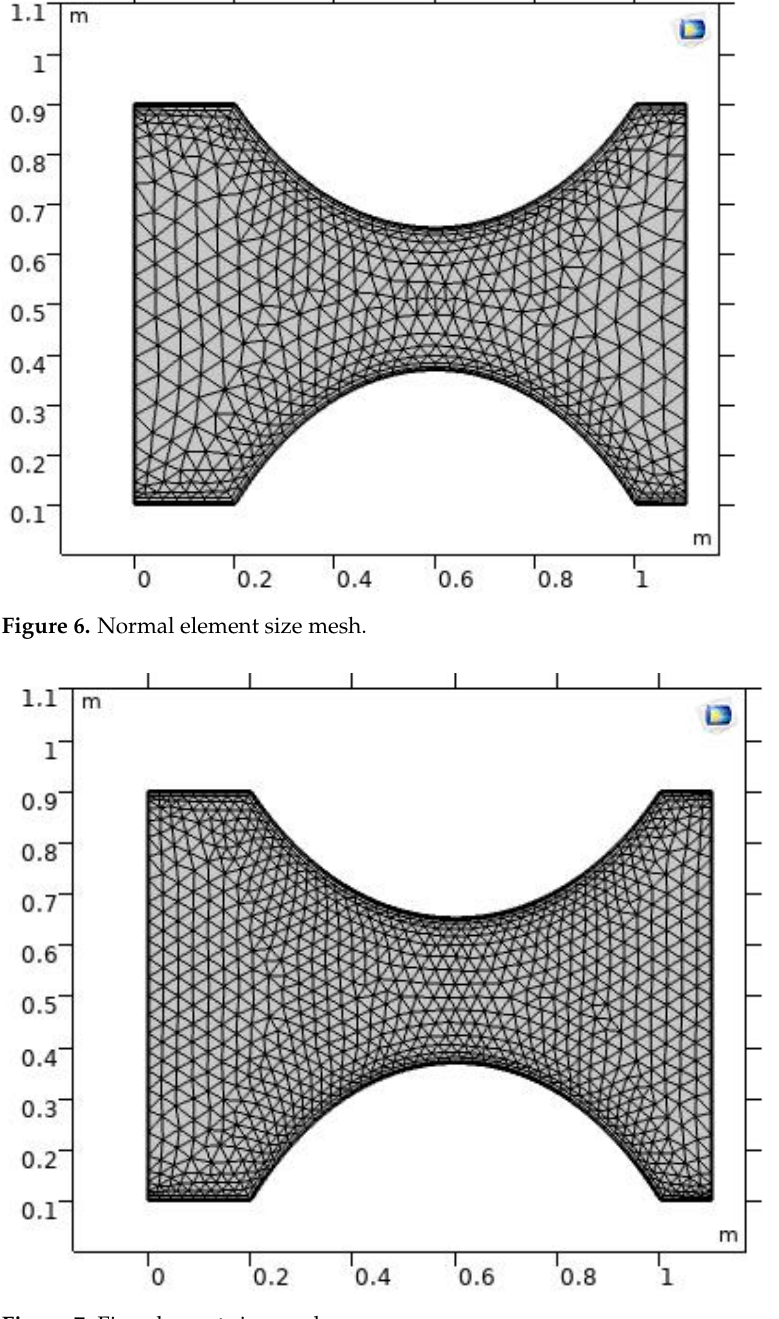
Figure 7. Fine element size